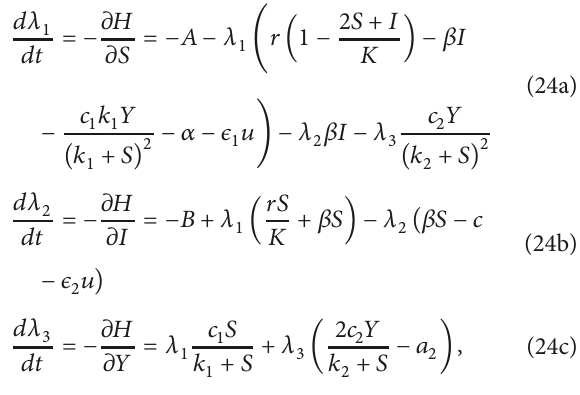
Figure 3: The stability regions of 𝐸 3 , 𝐸 5 and 𝐸 ∗ with respectto 𝑐 and 𝛼 . The parameter values are 𝑟 = 1,𝐾 = 1,𝛽 = 0.1, 𝑎 0.5, 𝑐 = 0.25, 𝑘 = 1 , and 𝑘 = 0.5 2 1 2